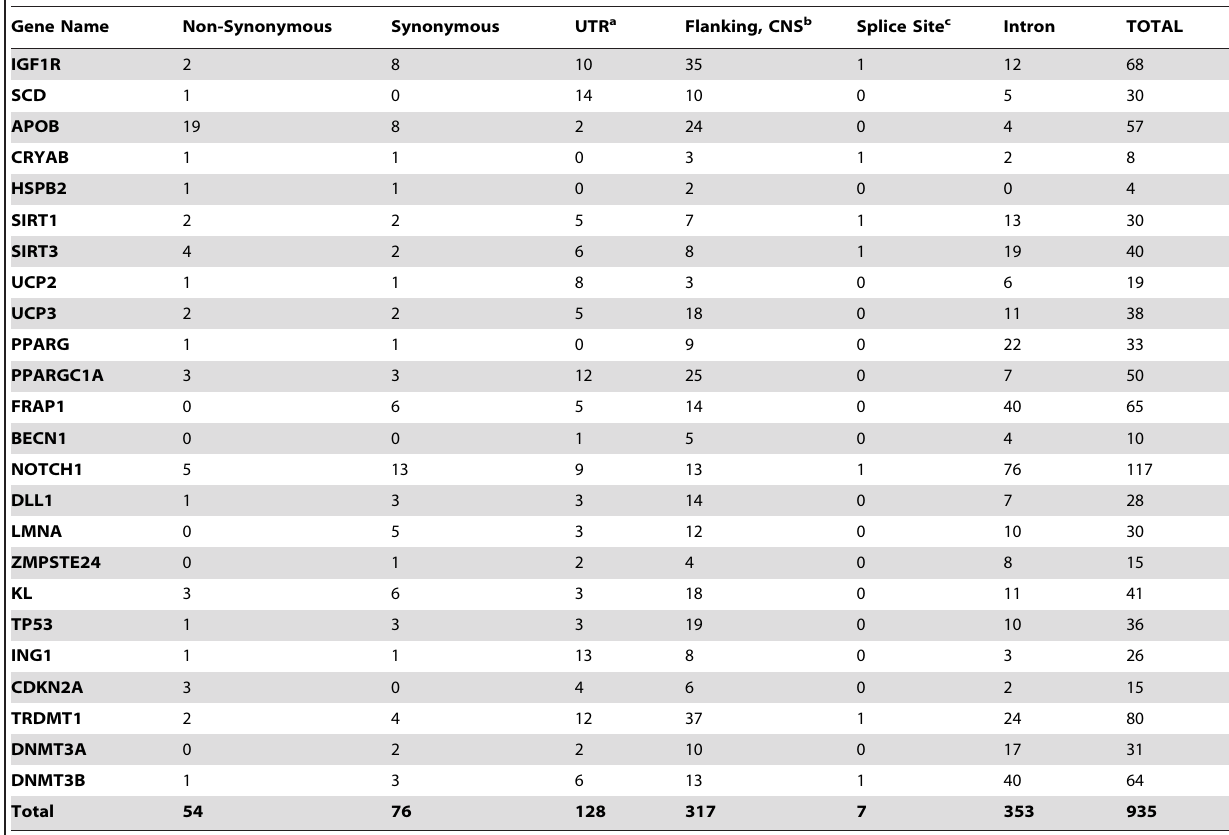
Table 3. Genomic location of